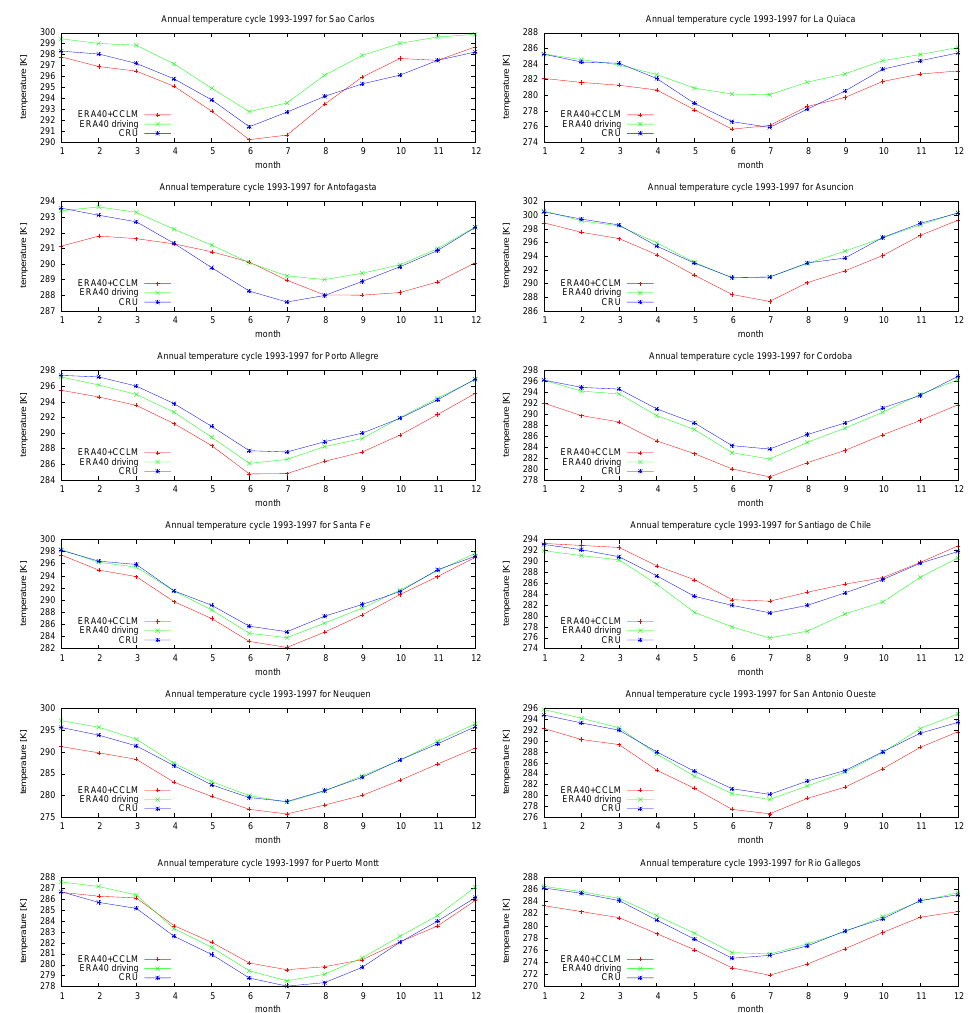
Fig. 2a. Model validation for the annual temperature cycle for the period 1993–1997 for grid points closest to a meteorological observation station entering the gridded product used for comparison. Red line: ERA40 + CCLM regional model output, green line: driving ERA40 re-analysis data used to drive the regional model, blue line: gridded CRU data based on observations.